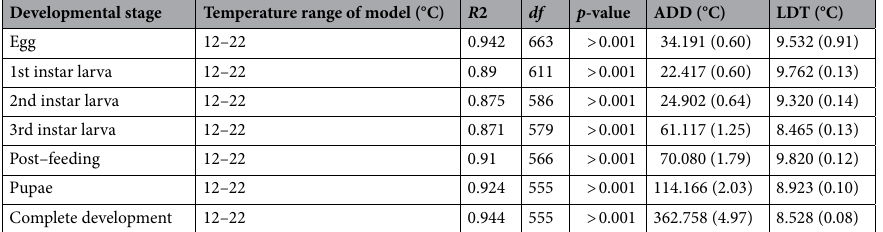
Table 3. Summary of the developmental constants for T. rugosus at six developmental stages. Standard errors shown in parentheses.